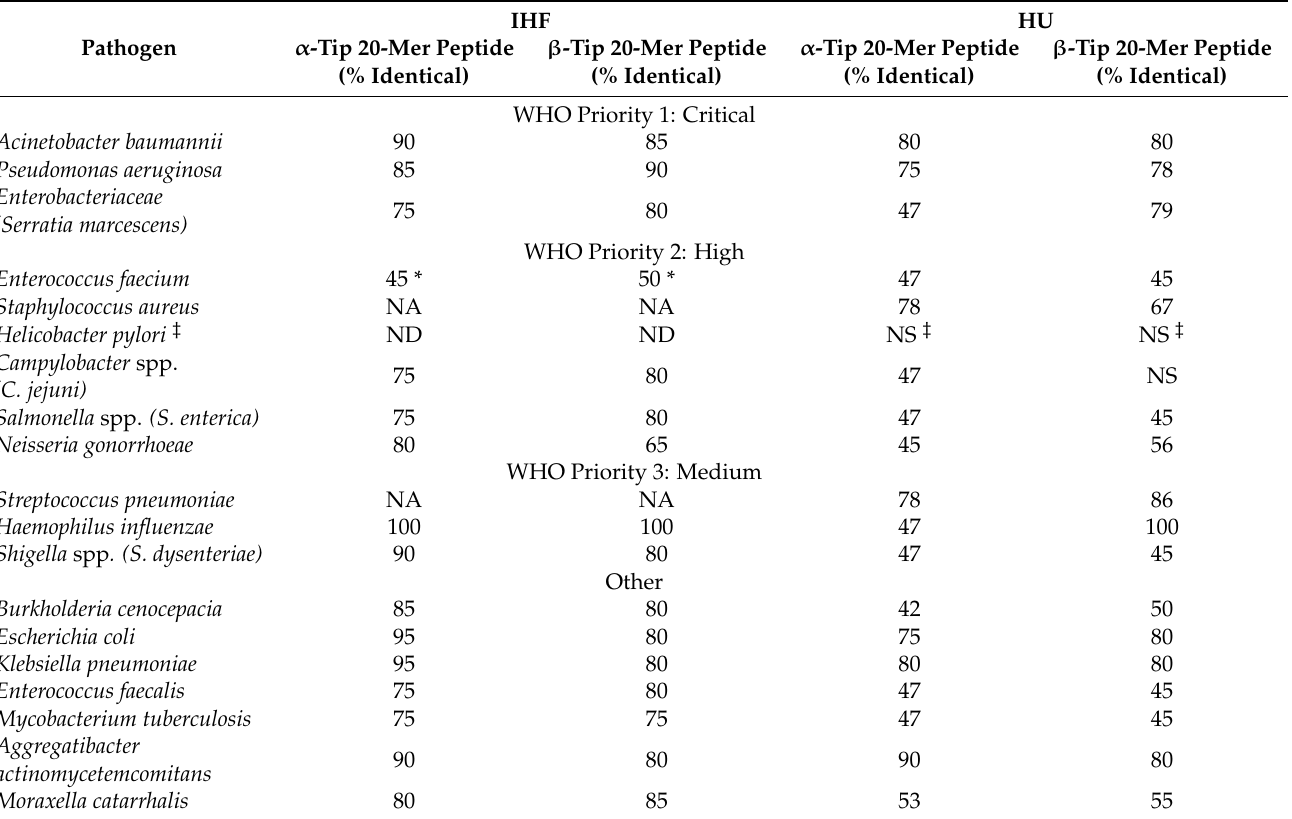
Table 1. BLAST search results for pathogens of interest showing amino acid sequence homology (% identical) for DNABII proteins (IHF and HU) compared to the α - and β -tip chimer peptide [48] used to generate CMTX-101.